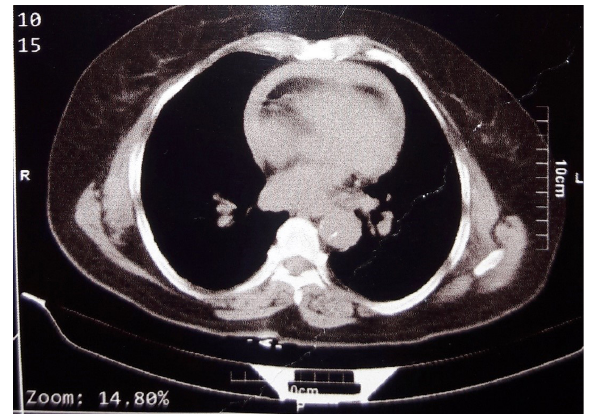
Figure 3. Perl Sign in Non-contrast CT-Scan. Note . CT: Computed tomography.